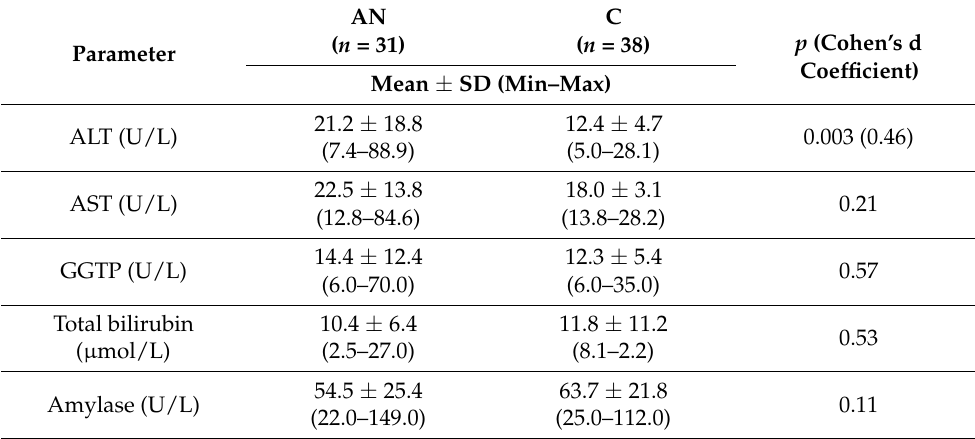
Table 2. Results of the biochemical and hormonal parameter assessment in the examined group of girls with anorexia nervosa (AN) and the healthy control